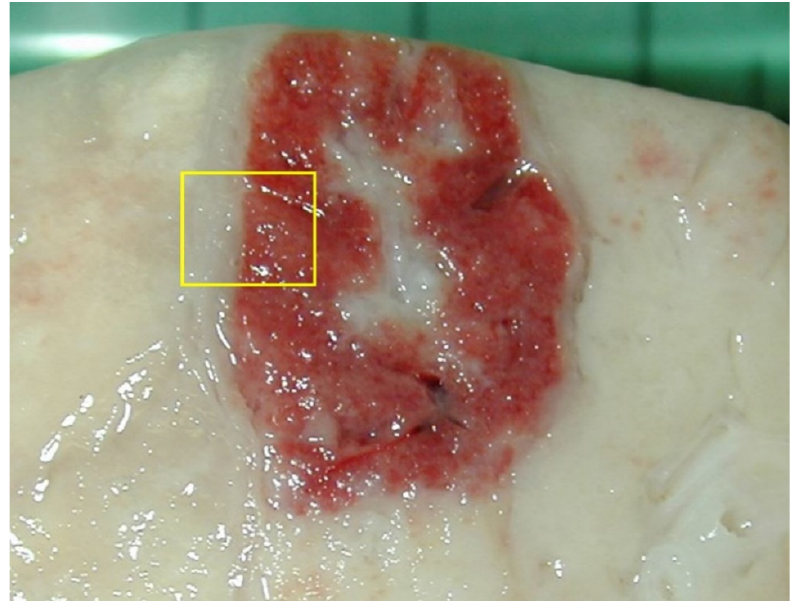
Figure 6. For histological examination, the lesions should never be collected in the center, since they often contain a complicated or necrotic lesion. A sample at the margin with the surrounding normal parenchyma (yellow box) allows one to identify the pathological process at its onset (in the peripheral part of the lesion) and its evolution (progressing in observation towards the center). If the lesions are small (1–2 cm), they can be sampled entirely; if they are larger, it is appropriate to take them from the margin, with some surrounding normal tissue.